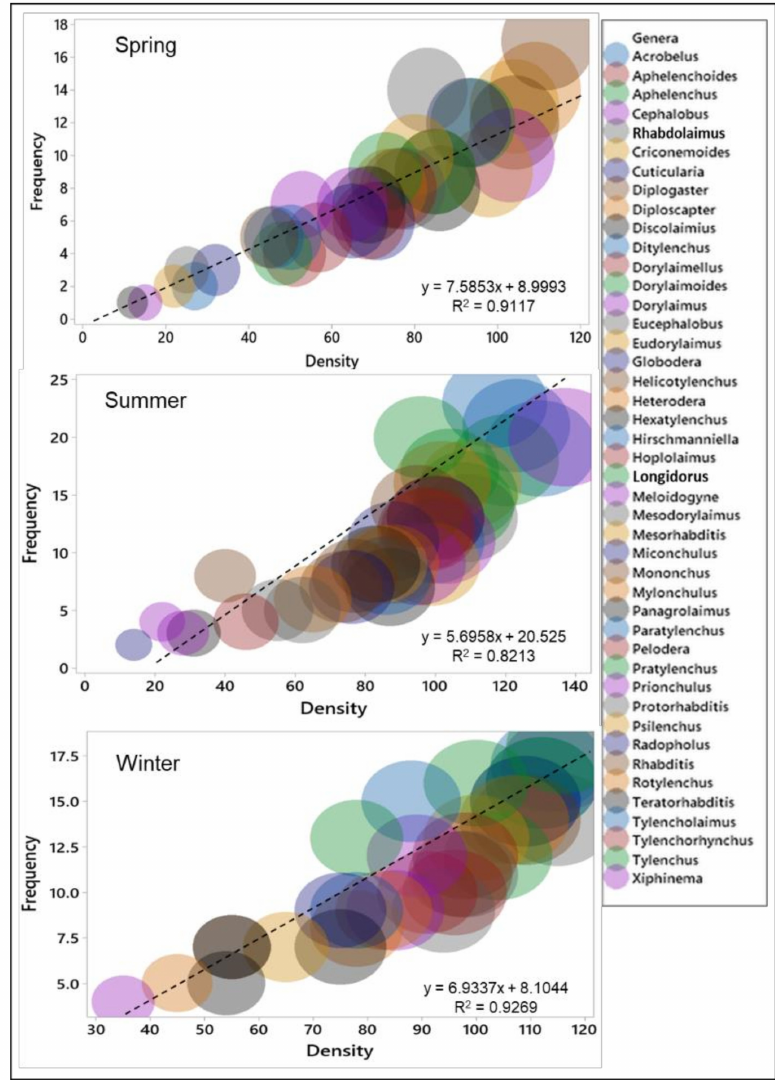
Figure 5. The frequency and density relation of soil nematodes during the spring, summer, and winter seasons of the year in the rice fields. Linear trendlines were obtained from mean data of the frequency and the density of the soil nematode genera; R 2 represents the correlation strength in the three